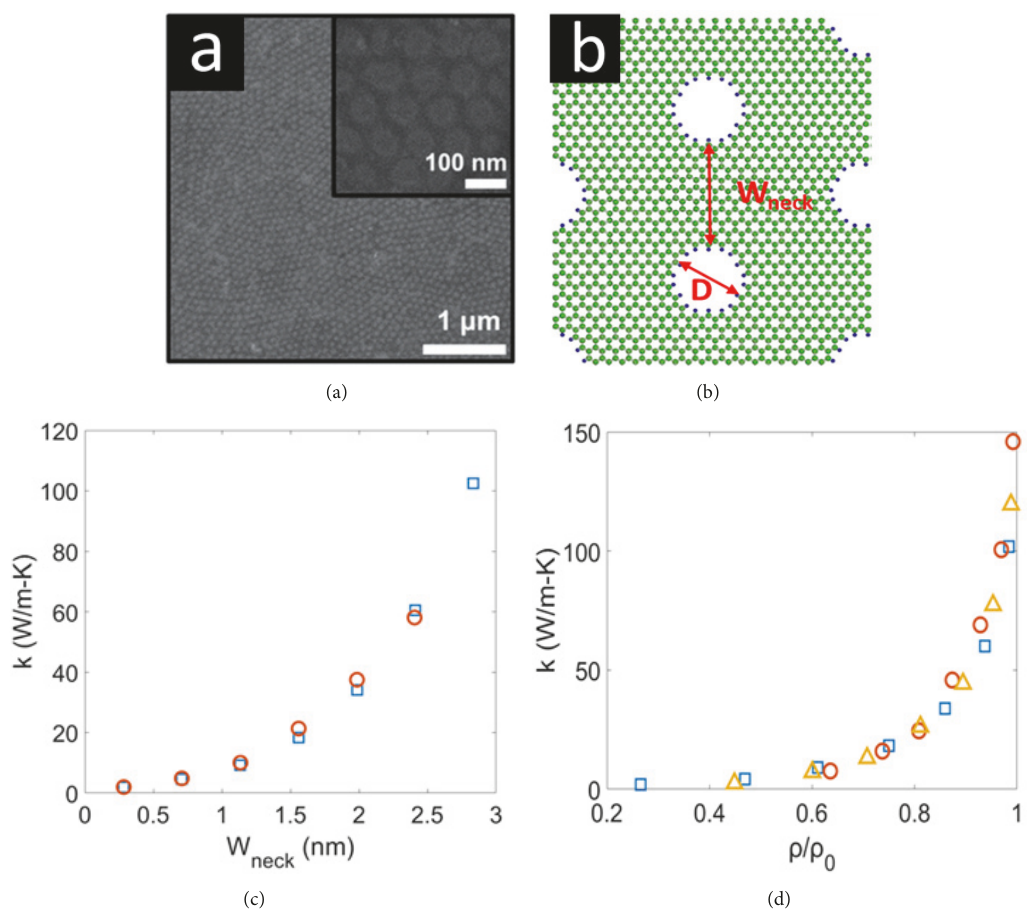
Figure 6: (a) Field-emission scanning electron microscopy image of graphene nanomesh. (b) Atomic structure of GNM, in which W neck and D are the neck width and diameter of the holes, respectively. (c) The thermal conductivity 𝜅 as a function of the neck width W neck [89]. (d) The thermal conductivity 𝜅 of GNMs as a function of the scaled density, 𝜌 / 𝜌 0, with circular pores arranged in hexagonal (squares), honeycomb (circles) and square (triangles) lattices [89]. Panels (a) and (b) are reproduced with permission [89,